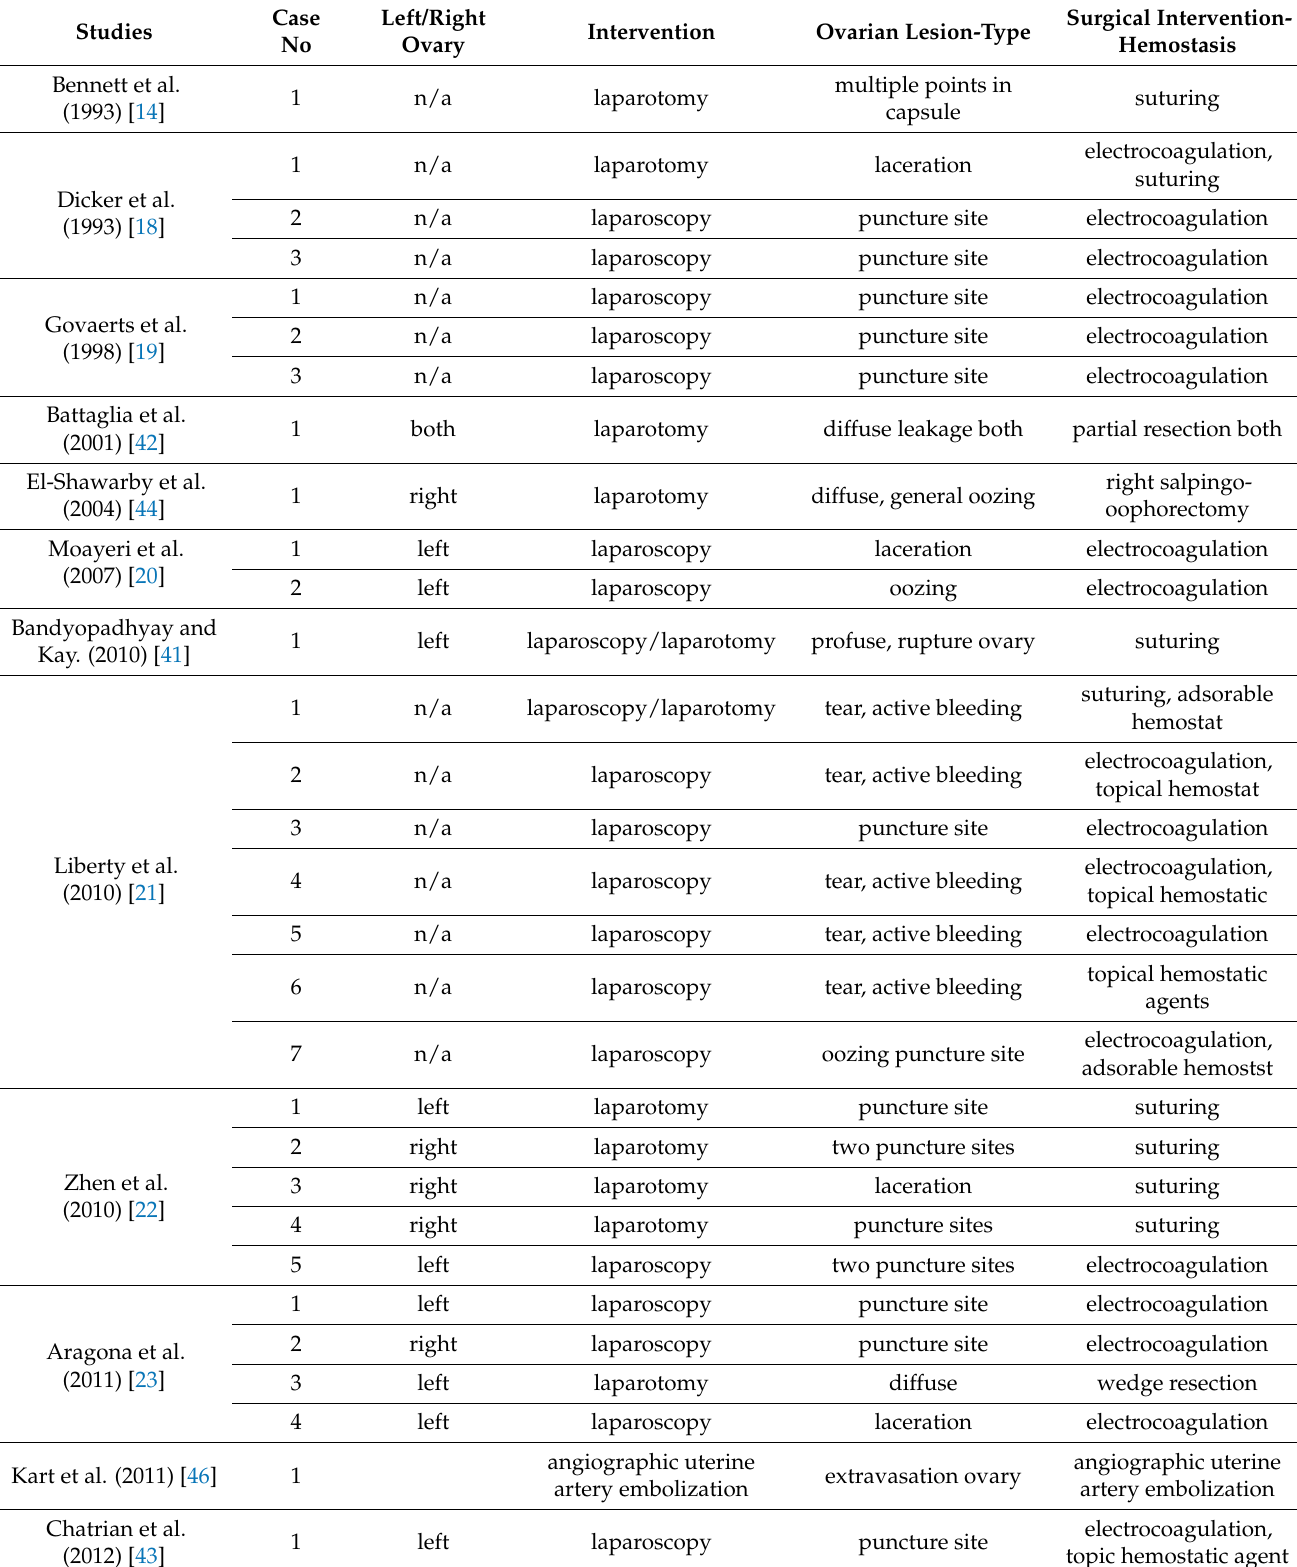
Table 4. Type of ovarian lesion, surgical management and hemostatic intervention after TVOR: a pooled